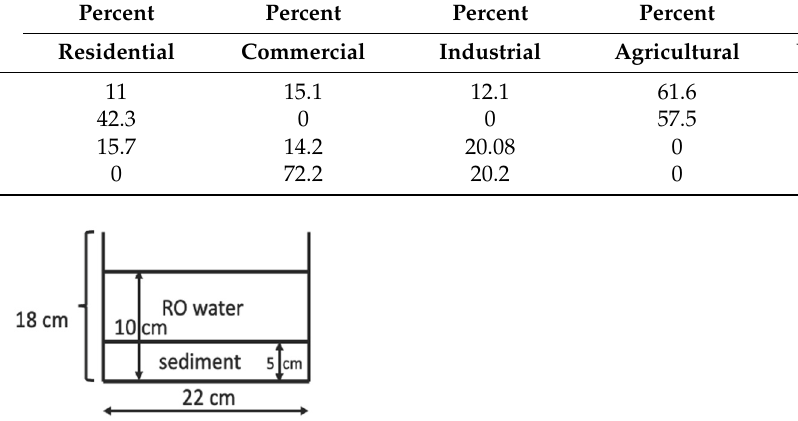
Figure 3. Schematic diagram of the microcosms with sediment and reverse osmosis (RO) water and sediment.